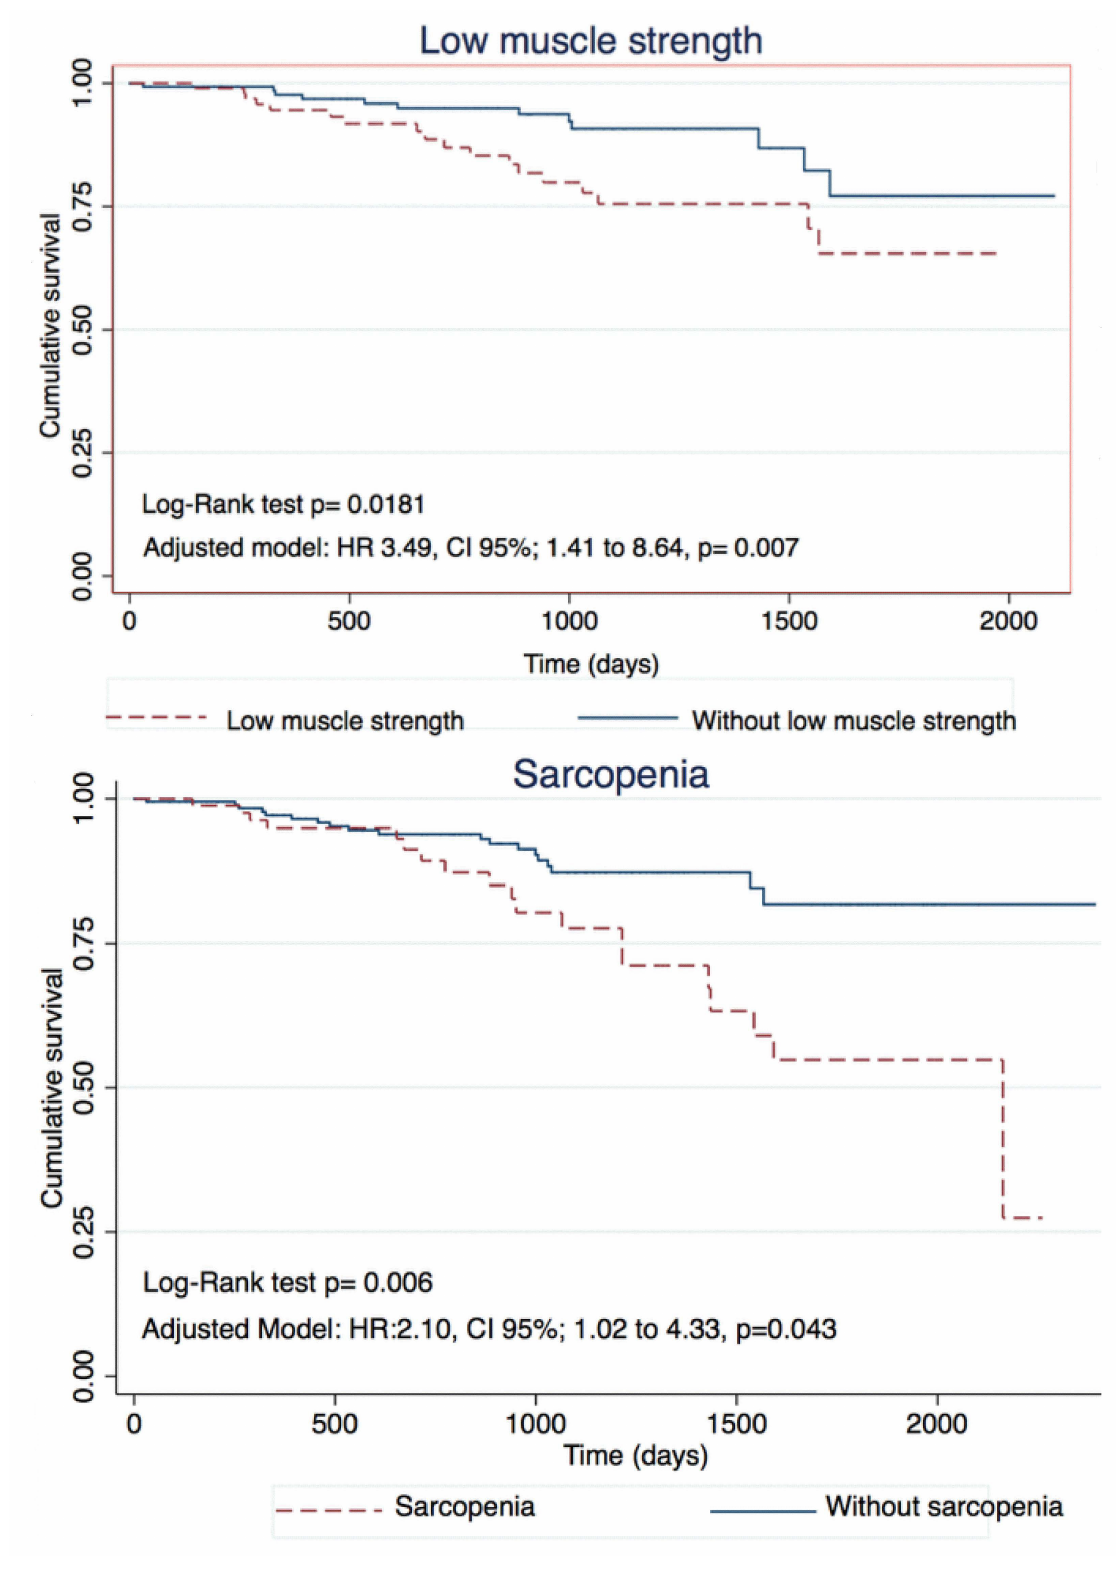
Figure 1. Kaplan–Meier curves for all cause